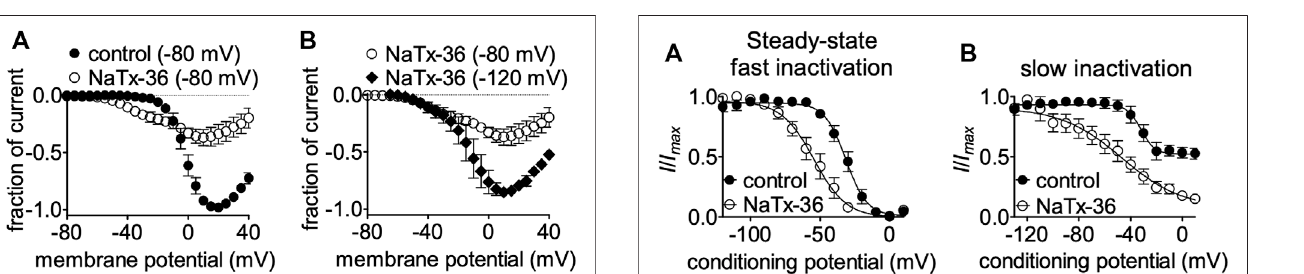
FIGURE 4 | Effects of NaTx36 on OtNa V 1.8 current-voltage relationship (I-V curves). Cells were pretreated with 500 nM TTX to block TTX-sensitive sodium channels, and currents were elicited by 50-ms depolarizing steps to various voltages ranging from − 80 to +40 mV in 5-mV increments. All Na + currents were normalized to the maximum amplitude of control peak current. (A) RepresentativeI-Vcurvesbeforeandafter100 nMNaTx36.When the holding potential was − 80 mV, NaTx36 could inhibit TTX-R Na + current recorded from ND7/23 cells transfected with recombinant OtNav1.8 (control, n =5;NaTx36, n =4).NaTx36alsoenhancedactivationbyhyperpolarizingthe membrane potential at which channels begin opening. (B) When the holding potentialwaschangedto − 120 mV,inhibitionofOtNa V 1.8by100 nMNaTx36 was substantially reduced ( − 80 mV, n = 4; − 120 mV, n = 3).